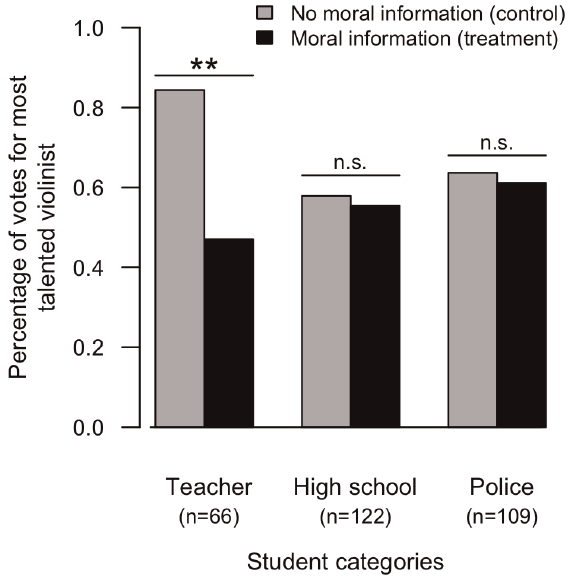
Figure 1. Proportions of votes for the most talented violinist among teacher, high school and police students when they received the moral information–i.e. she is immoral–(black bars) or when they received the neutral information–i.e. she is socially integrated–(grey bars). Significance levels (mixed-effect GLM): **=p , 0.01, n.s.=p . 0.05.